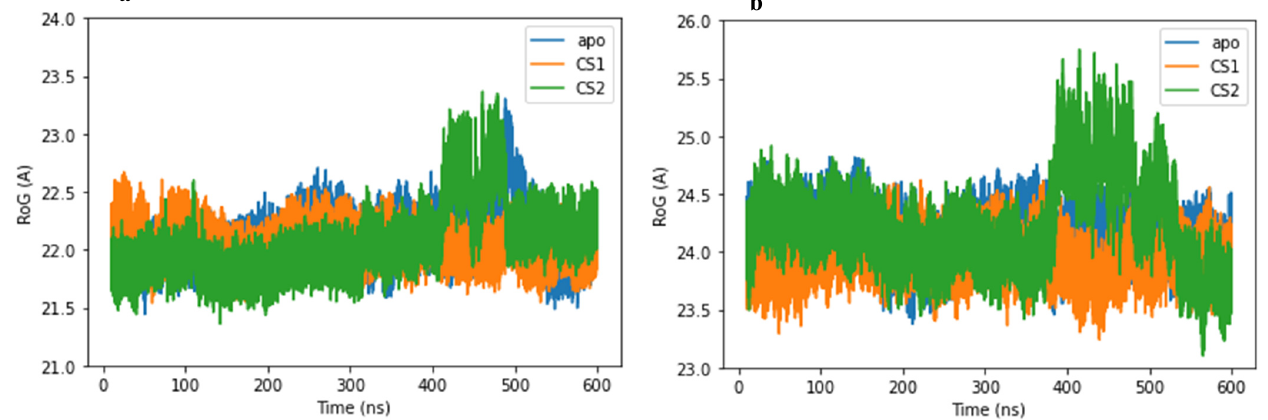
Figure 6. Radius of gyration plot for ( a ) apo-3CLpro protease (blue) and complexes of 3CLpro with CS1 (orange) and CS2 (green) during the 600 ns MD simulation time. ( b ) apo-PLpro protease (blue) and complexes of PLpro with CS1 (orange) and CS2 (green) during the 600 ns MD simulation time.